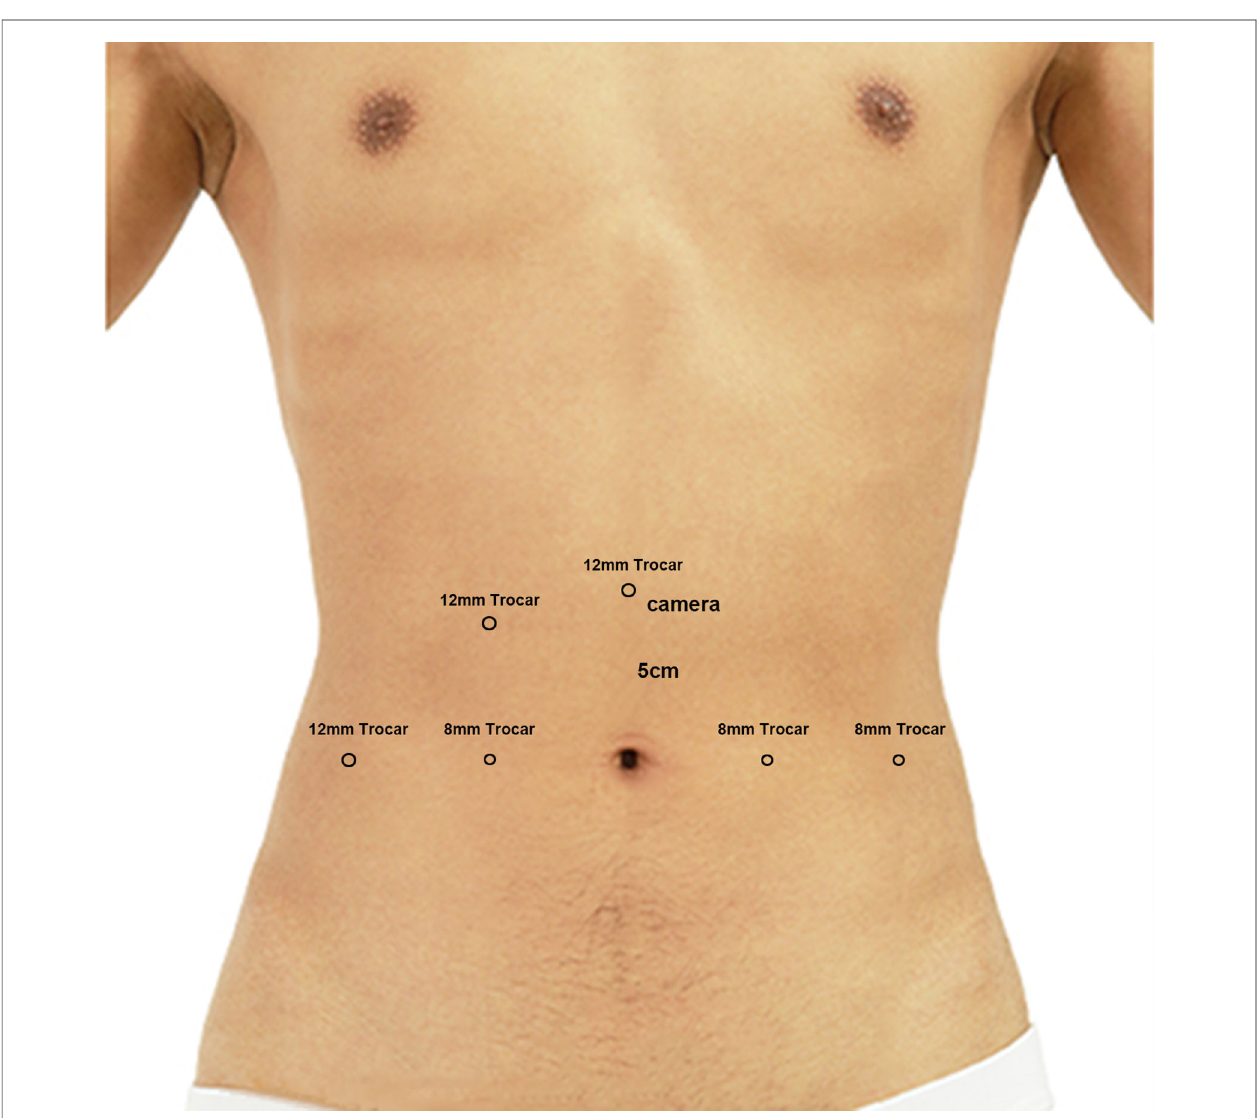
FIGURE 1 | A fi ve-port transperitoneal